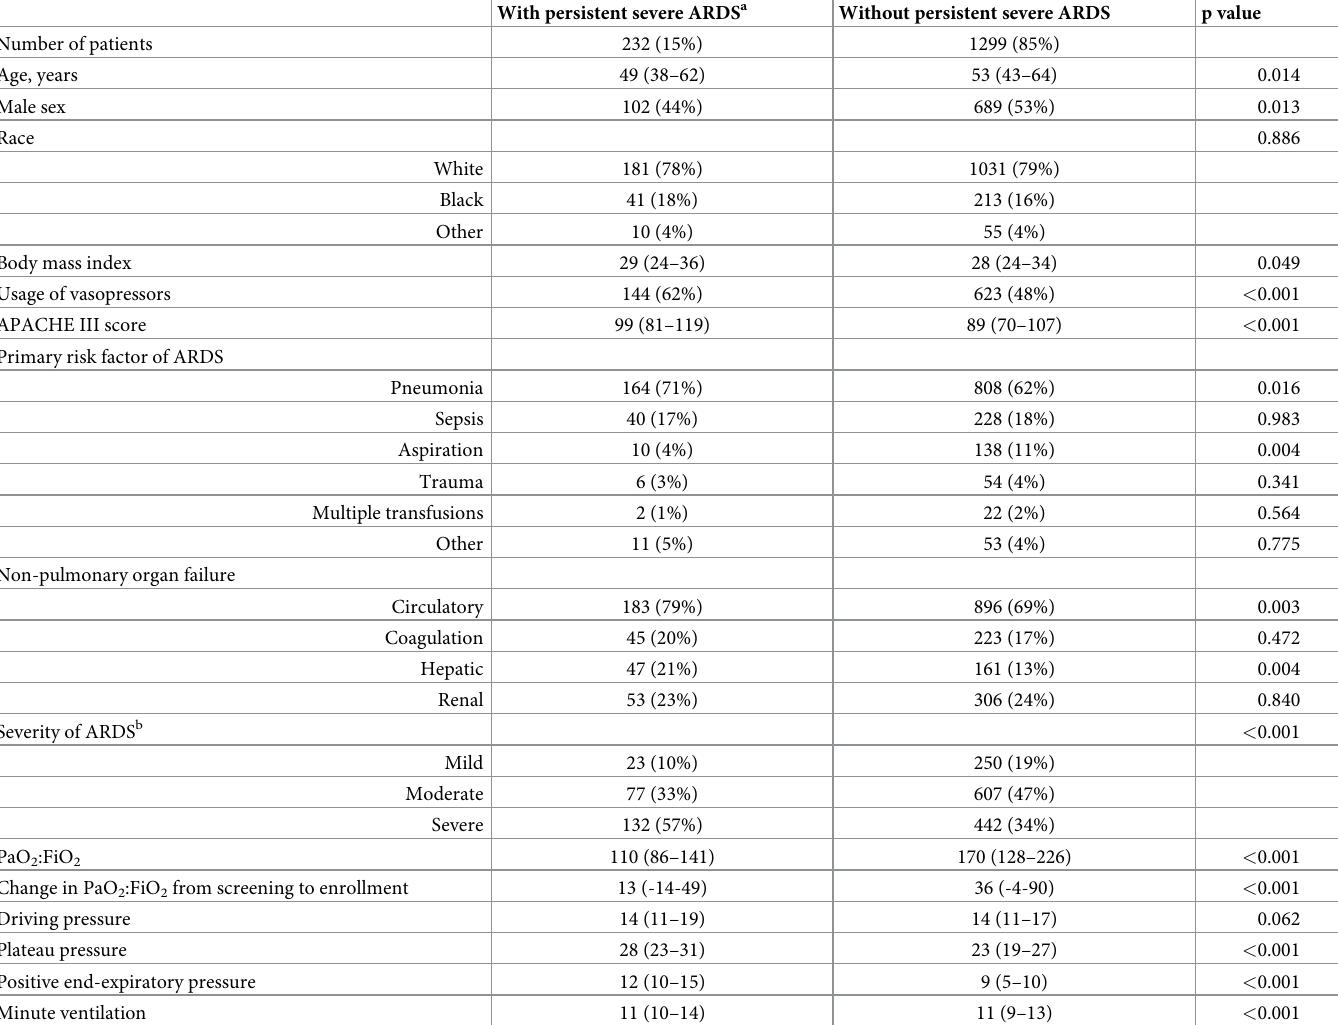
Table 1. Baseline characteristics of patients with versus without persistent severe